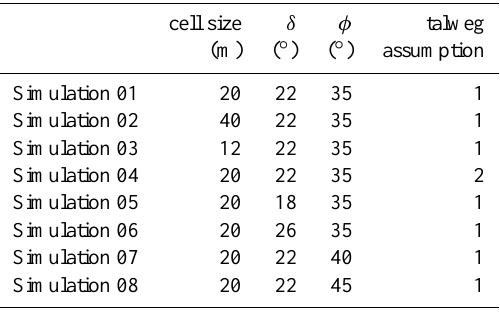
Table 3. Parameter combinations applied for the simulations.